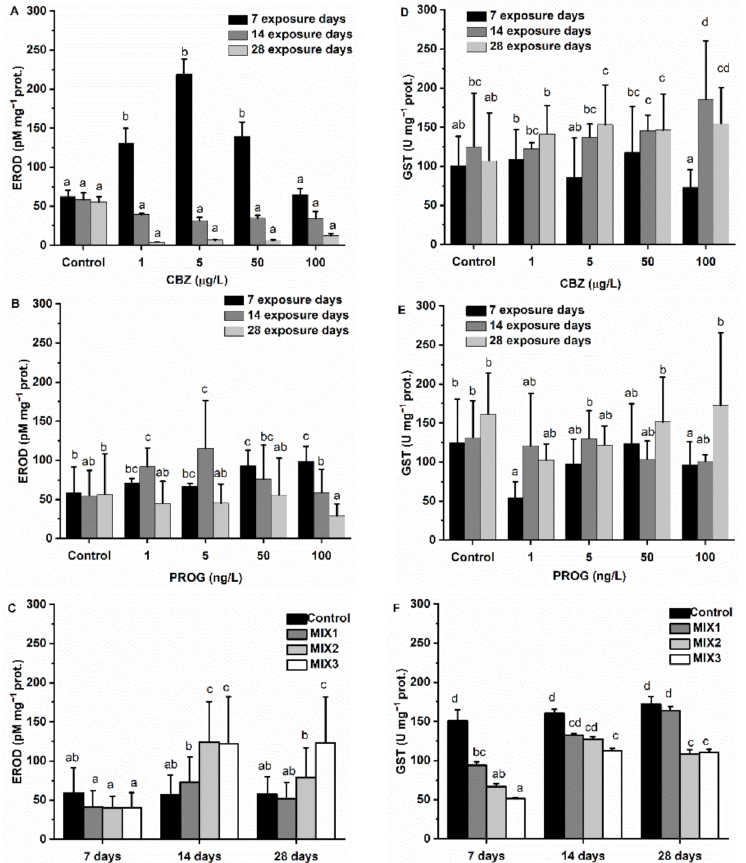
Figure 3. Changes of biotransformation enzymes’ activity—hepatic EROD ( A – C ) and GST ( D – F ) in the liver of Danio rerio exposed to ( A , D ) CBZ, ( B , E ) P4, and ( C , F ) binary mixtures of CBZ and P4 for 7, 14, and 28 days. Data are expressed as mean ± standard deviation of fifteen replicates ( n = 15). Different letters show significant differences at p < 0.05 after a two-way ANOVA followed by Tukey’s post hoc